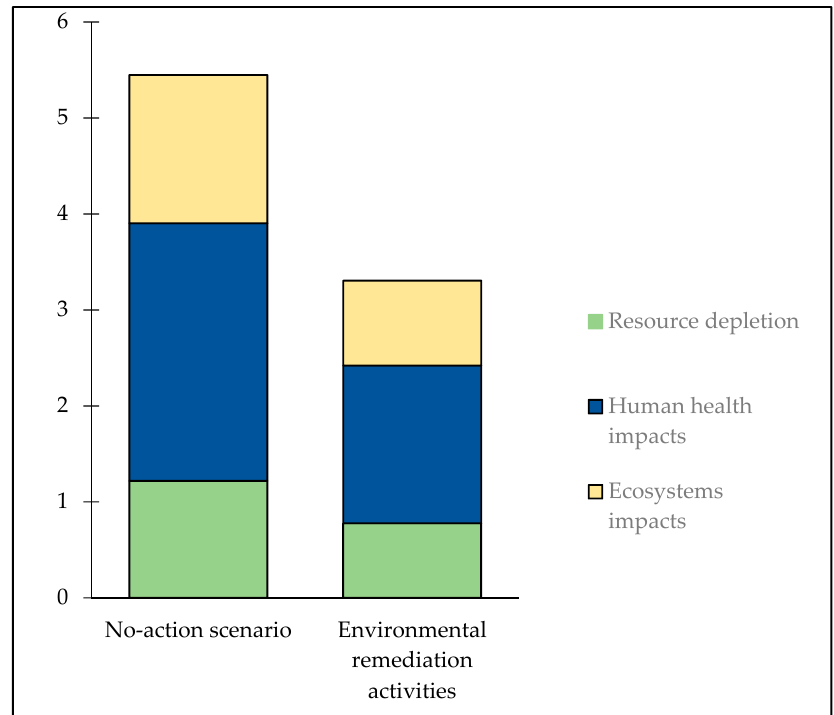
Figure 2. End-point results of LCA (Life Cycle Analysis) categorized by type of final affectation.